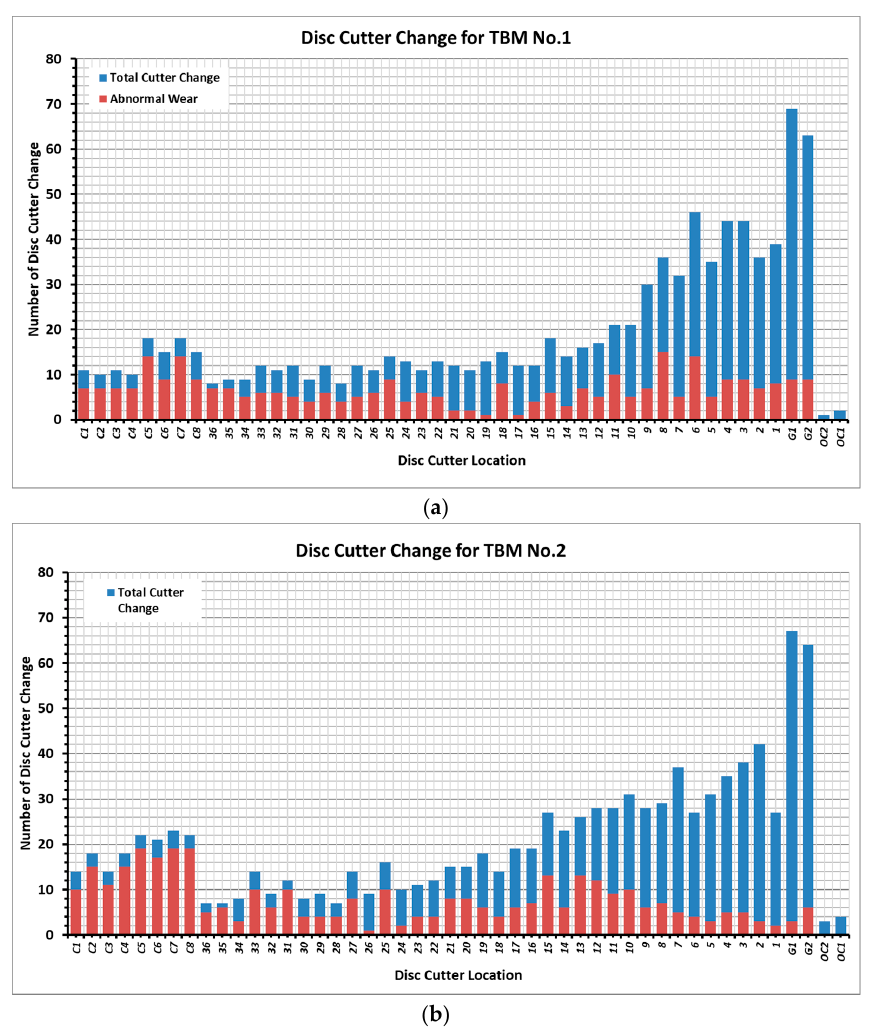
Figure 7. Number of disc cutters changed: ( a ) TBM No. 1; ( b ) TBM No. 2.